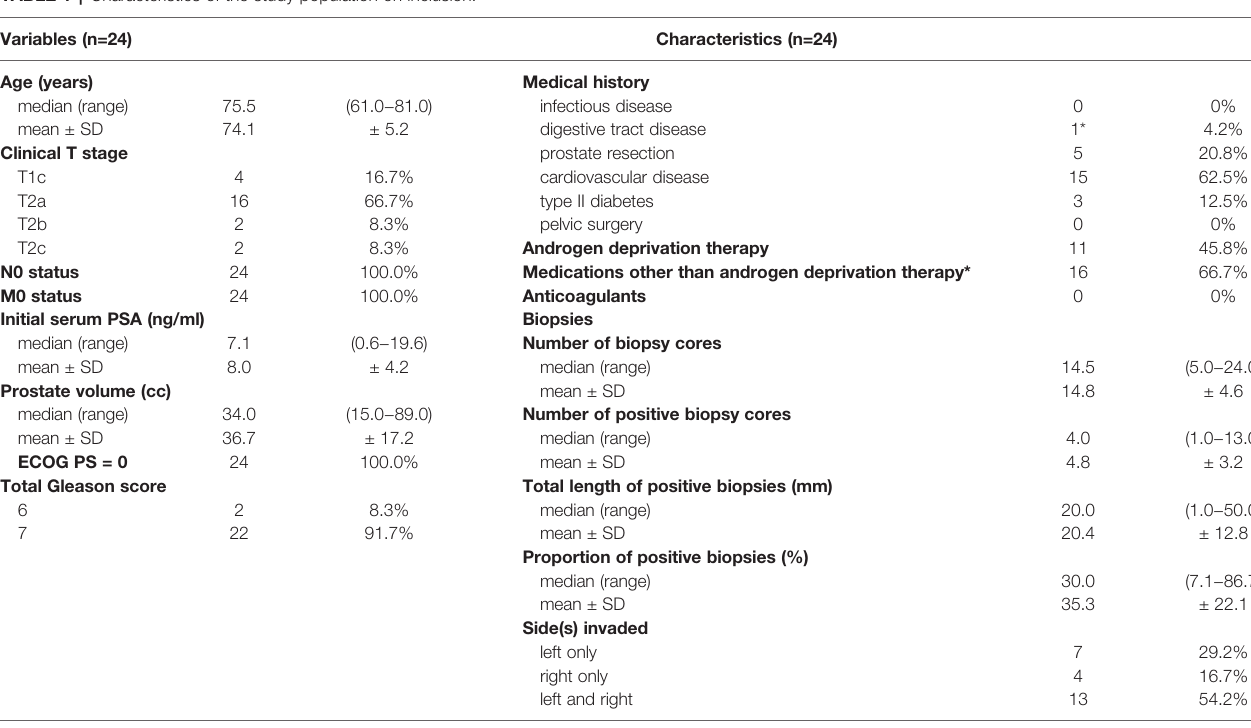
TABLE 1 | Characteristics of the study population on